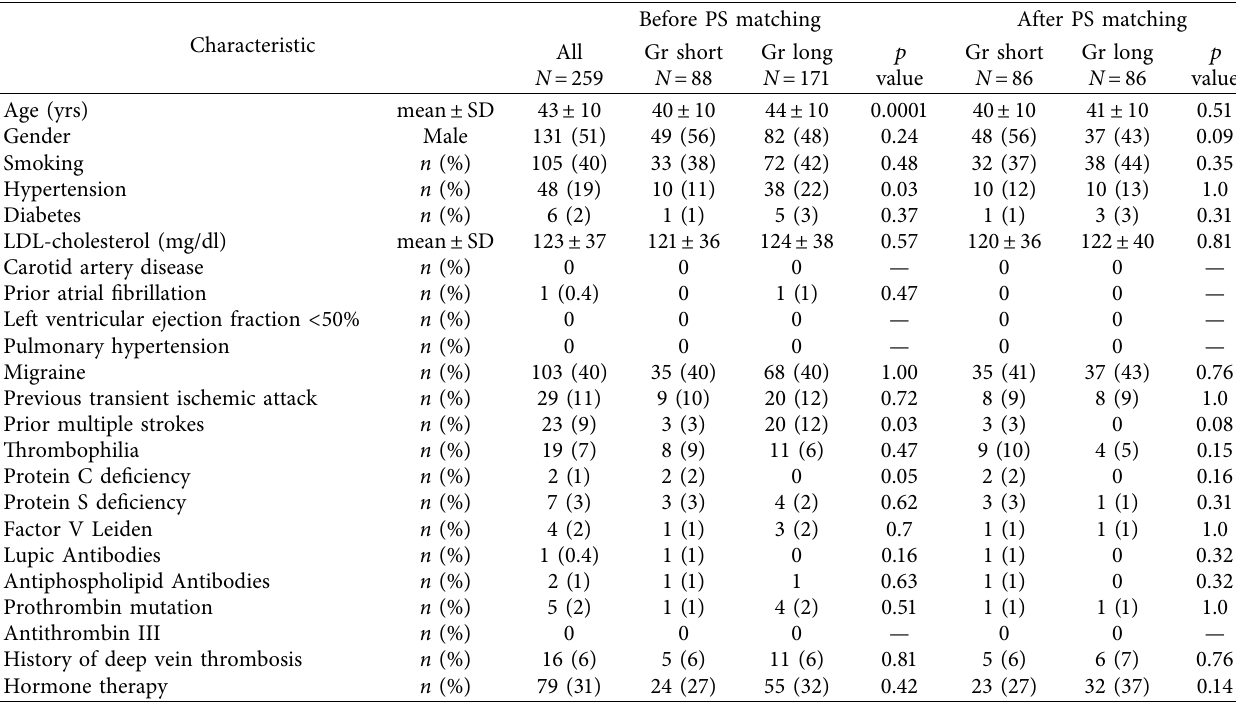
Table 1: Baseline characteristics of